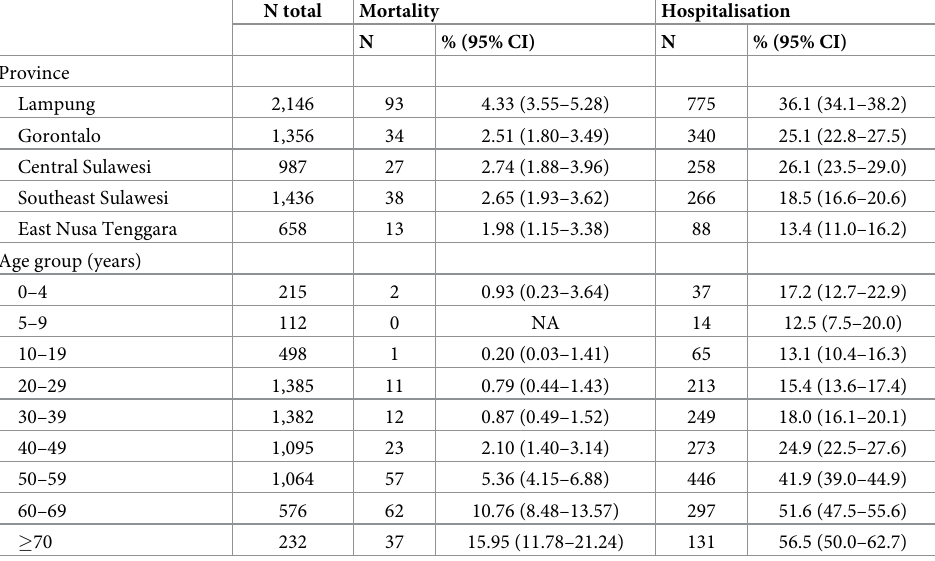
Table 2. Province and age-specific mortality and hospitalisation rate with confidence limits among COVID-19 confirmed cases in five rural provinces in Indonesia, 1 January to 31 July 2021. N total